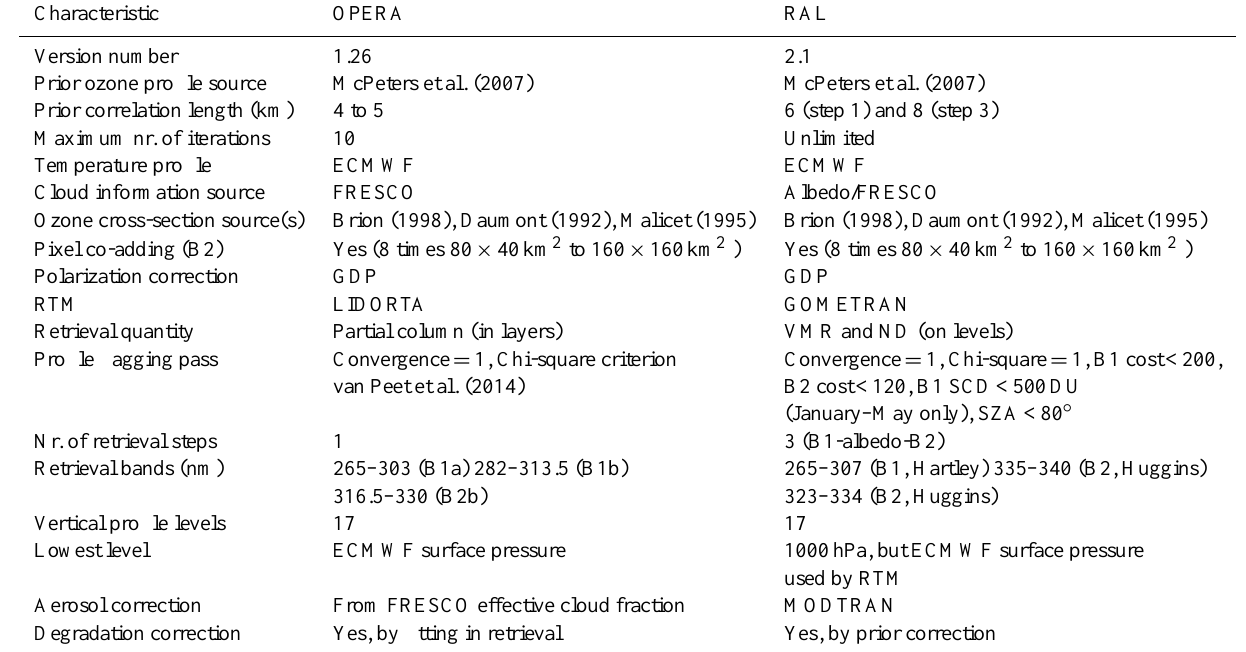
Table 1. Main OPERA and RAL nadir ozone profile retrieval scheme characteristics and input parameters (for RR algorithms under study, not necessarily corresponding to latest